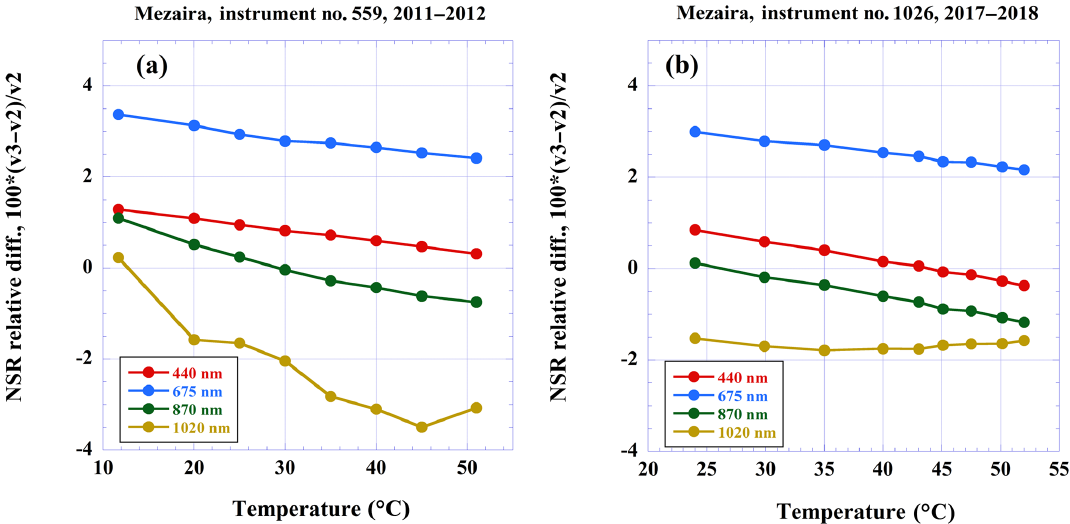
Figure 5. Effect of solar spectrum and temperature correction on relative percent difference in NSR for Mezaira (a) instrument 721 and (b) instrument 1026.